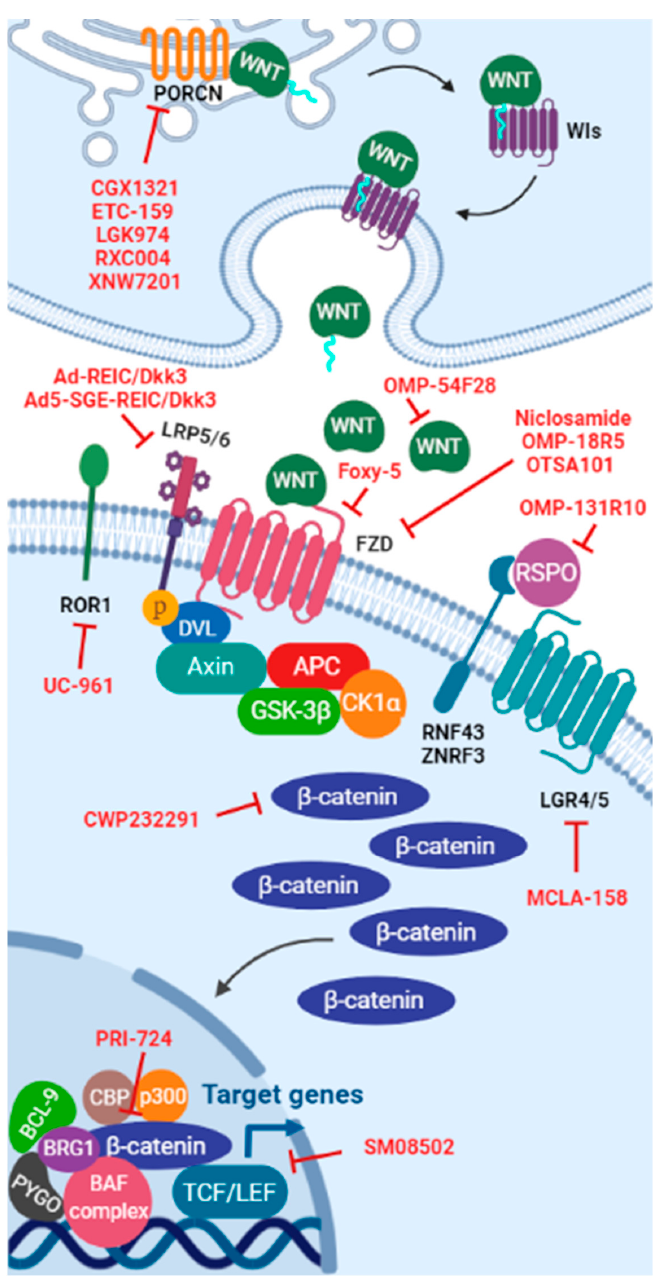
Figure 3. WNT signaling pathway inhibitors. Scheme of the WNT signaling pathway showing the interaction site of each WNT inhibitor include in clinical trials. Of the 44 clinical trials focusing on targeting WNT signaling pathway on cancer treat- ment, 39 trials (89%) have as a target WNT-upstream members, while only 5 of them (11%)